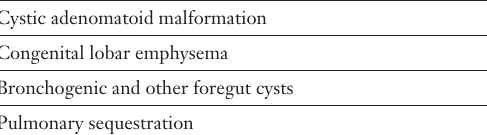
Cystic malforma-